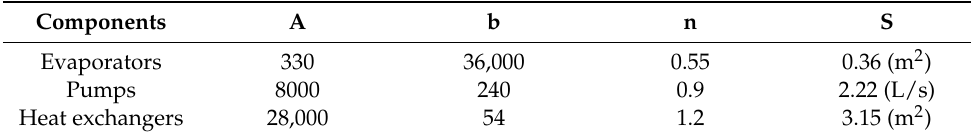
Table 3. Cost constants and size parameters.